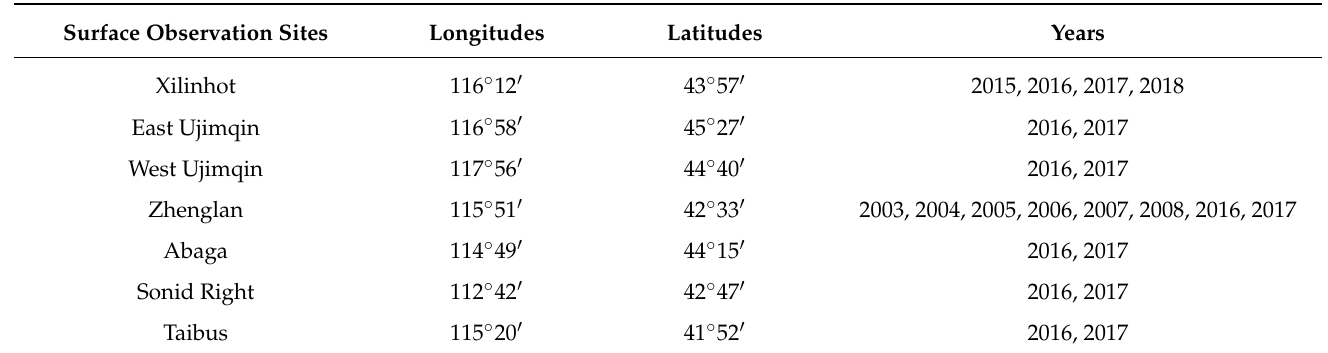
Table 1. The specific times and geographical locations of surface observation